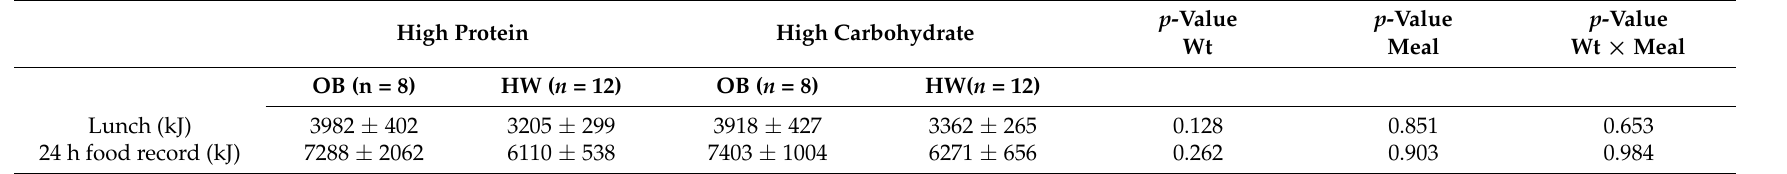
Table 3. Subsequent energy intake in adolescents after high-protein and high-carbohydrate meals. High Protein High Carbohydrate